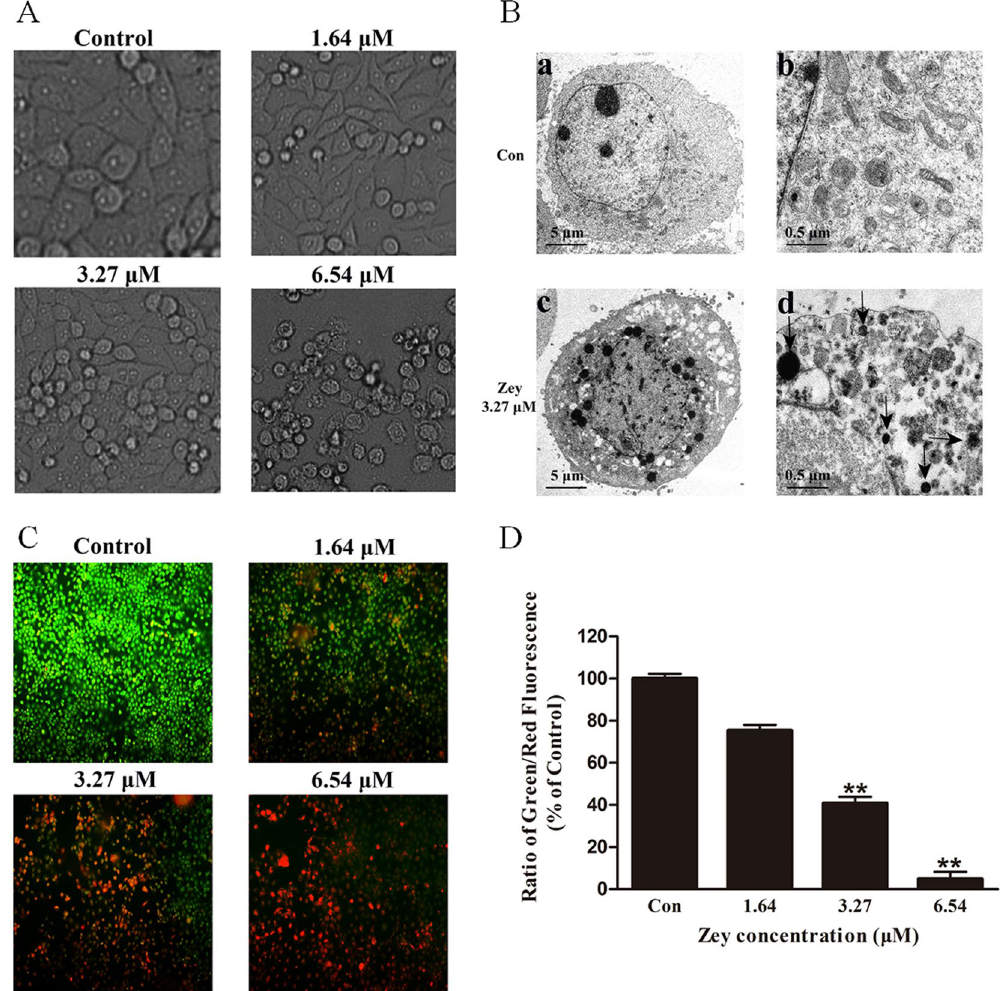
The arrows indicate condensation and margination of nuclear chromatin surrounding in the nucleus. ( C ) Morphological observation with AO/EB double staining. ( D ) Statistical analysis of the Green/Red fluorescence ratios. ** P < 0.01 versus control